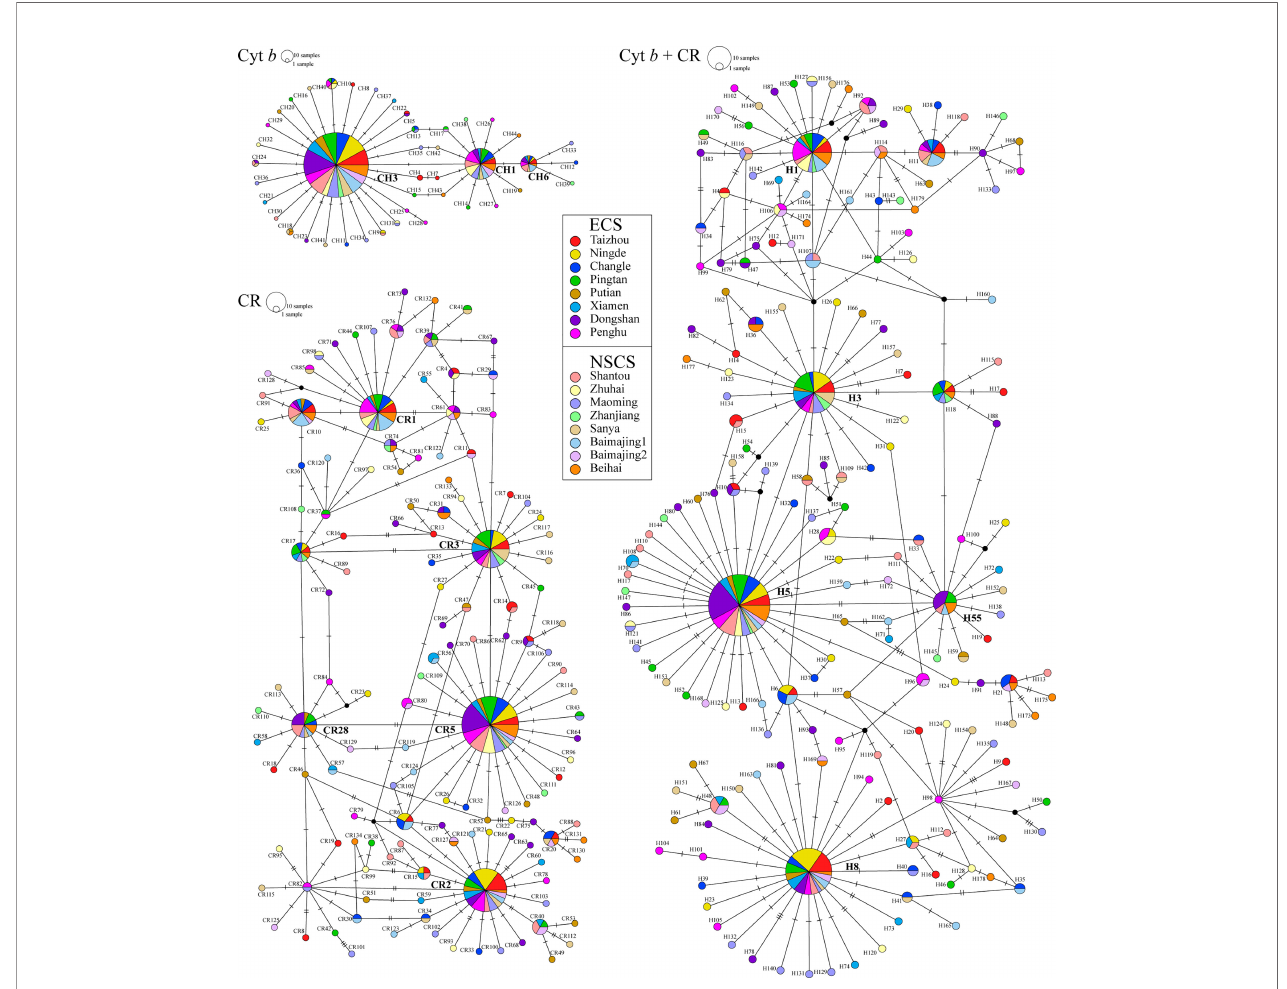
FIGURE 3 | Unrooted TCS haplotype network for Cyt b , CR, and concatenated sequences (Cyt b + CR) haplotypes of D. maruadsi .